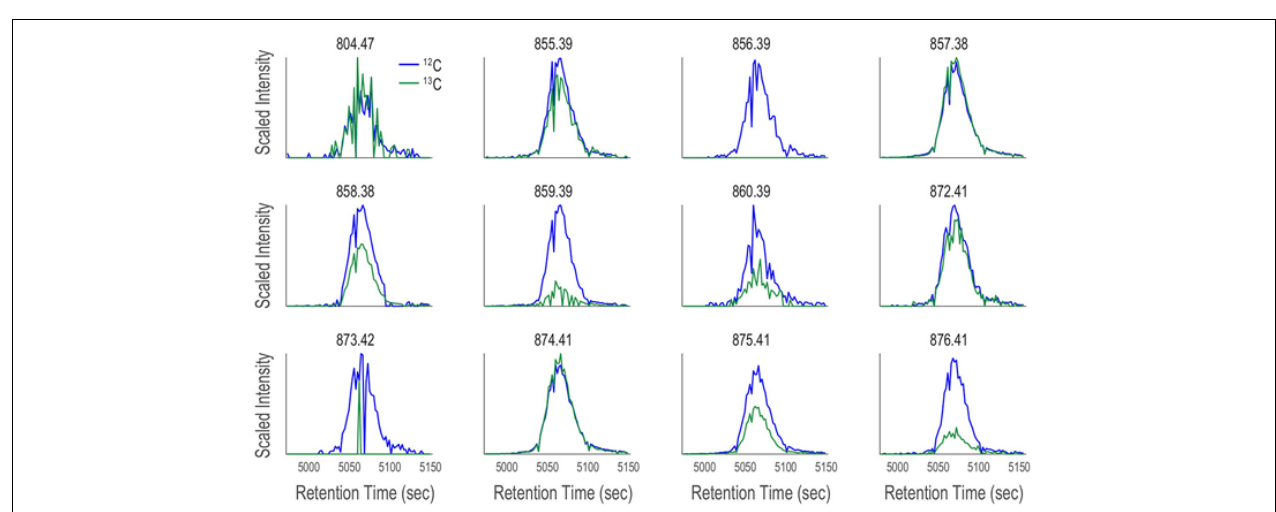
FIGURE 6 | Illustration of the compound mass assignment-time (CMA-T) algorithm. (A) The ion at 857.38 D targeted by CMA-T has the rise and fall in intensity with time expected for a well-shaped peak eluting from the LC. (B) The integral of the square of the 857.38 D ion intensity (I 2 ) over time (cid:49) T (T 95 -T 5 ) rises from 0.05% (T 5 ) to 0.95% (T 95 ) of its total value in (cid:49) T ≤ 0.2T w . (C) Ions that arise from noise show a more gradual rise and fall in intensity over time, and (D) for the same (cid:49) T, the integral of I 2 between T 5 to T 95 ≥ 0.2 T w . The comparison between (cid:49) T (T 95 -T 5 ) and 20% T w is used as a filter to differentiate target ions from noise.